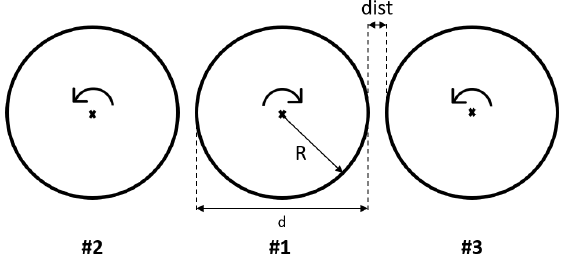
Figure 3. Sketch of the analysed configurations, front view: twin-propellers configuration (#1 and #2); three-propellers configuration (#1, #2 and